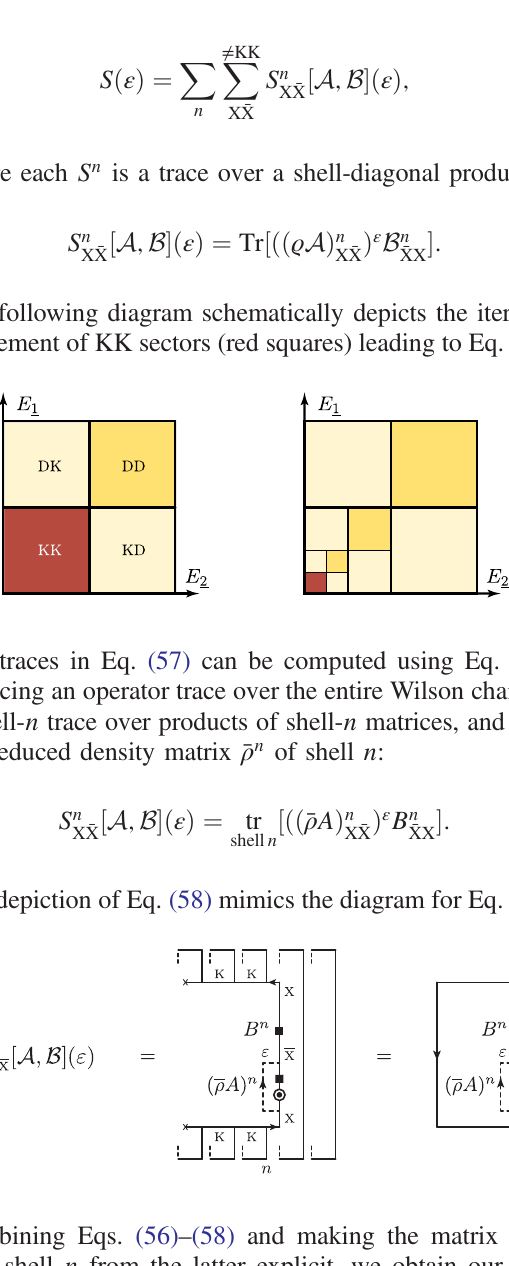
Combining Eqs. (56) – (58) and making the matrix